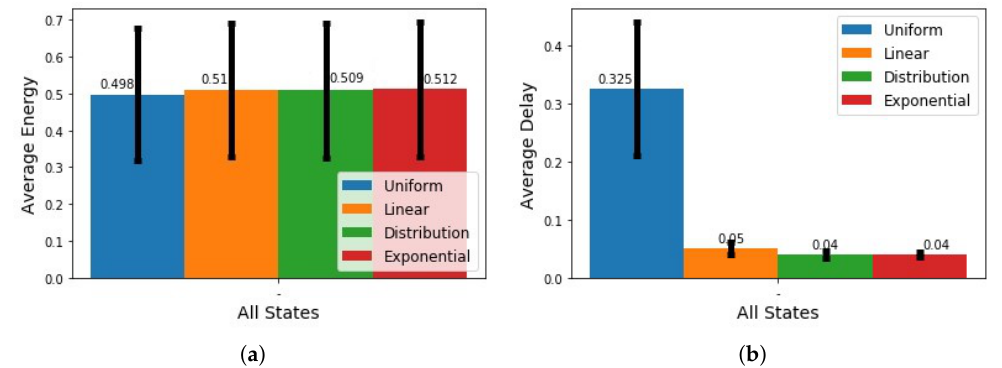
Figure 17. ( a ) Average normalized energy consumption values for all context scenarios using the different survival probabilities: ( b ) average normalized delay values for all context scenarios using the different survival